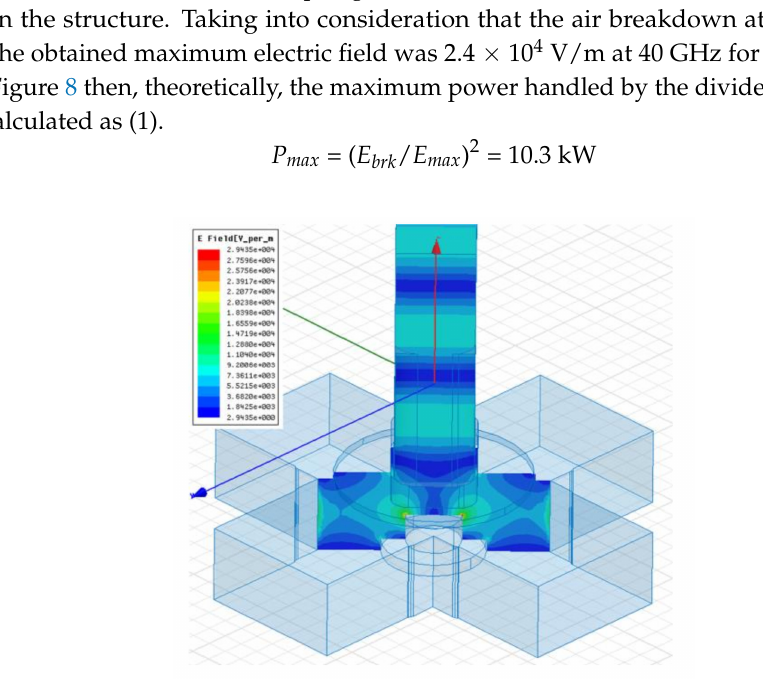
Figure 8. Simulation of the electric field within the junction. The maximum value is obtained at the sharp edges of the central